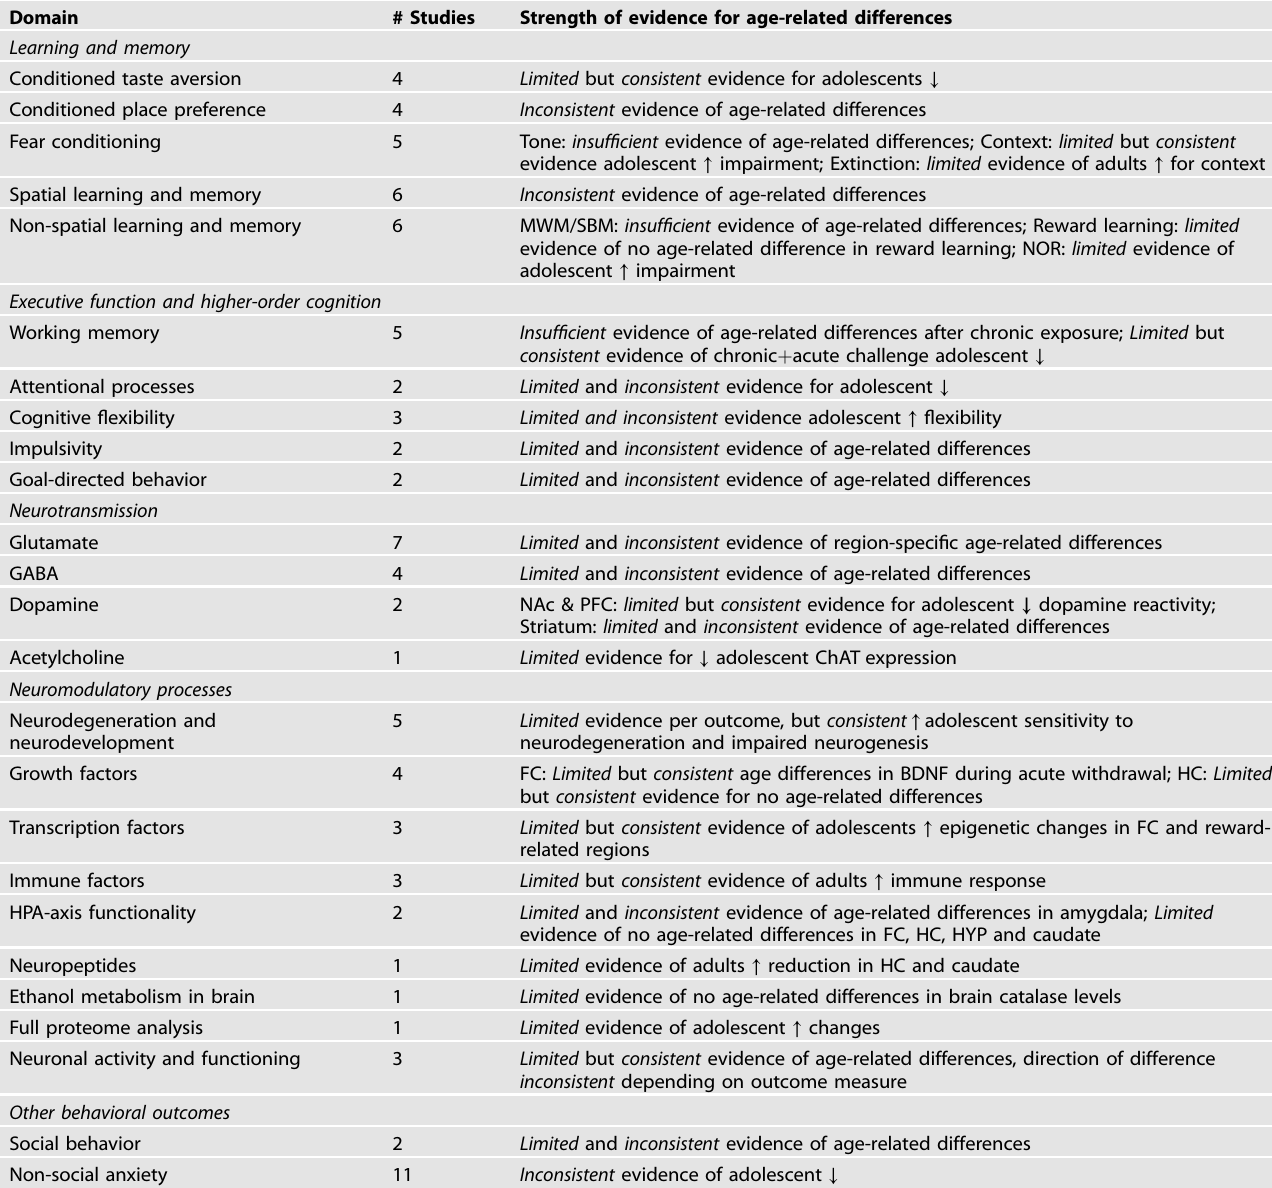
Table 3. Overview of the strength of evidence for cognitive and neurobiological outcomes in animal